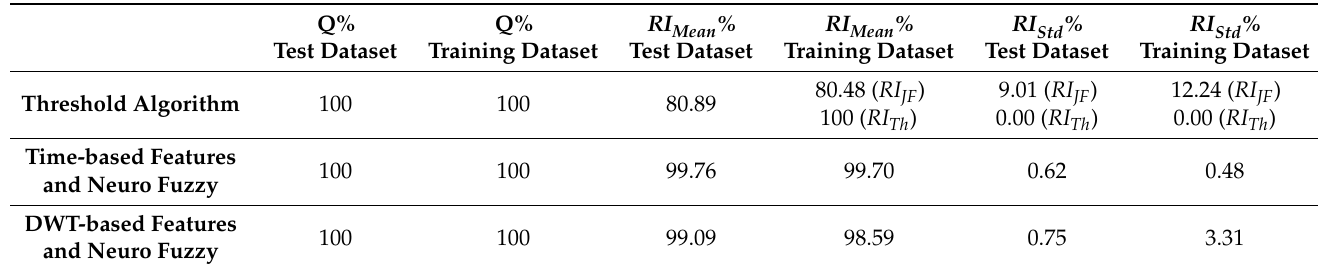
Table 3. Main features adopted through this work to implement algorithms for the analysis of postural